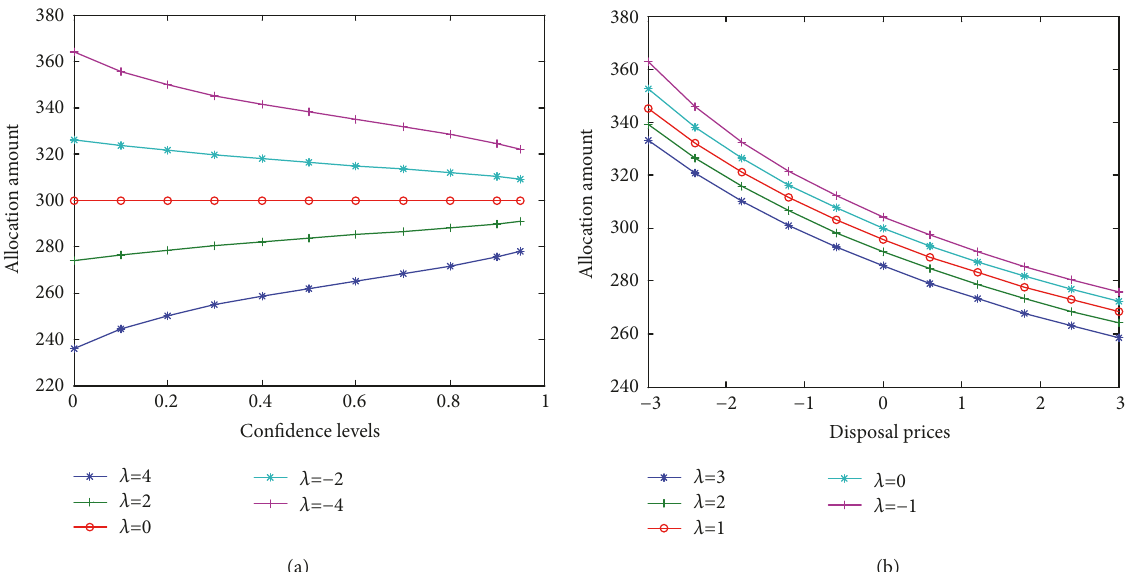
Figure 1: (a) Allocations at different confidence levels and multipliers 𝜆 ∗ . (b) Allocations at different disposal prices and multipliers 𝜆 ∗